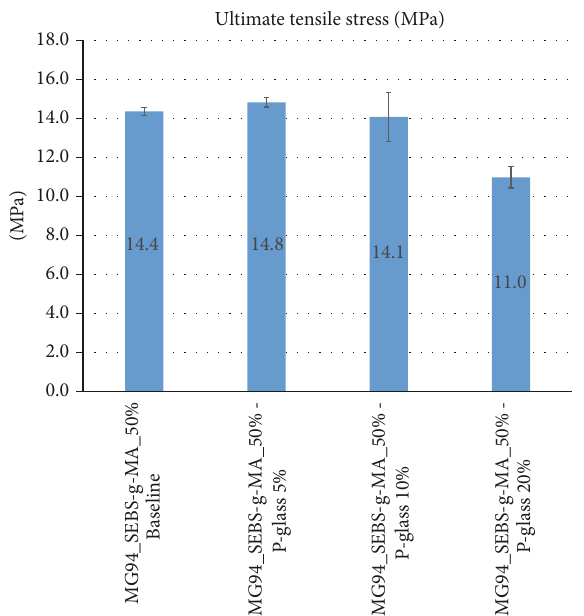
Figure 11: UTS values for the ABS:SEBS-g-MA/P-glass systems.